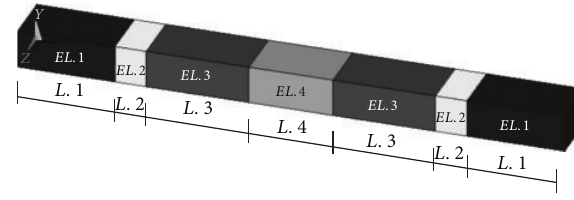
Figure 1: FE model of the uncracked